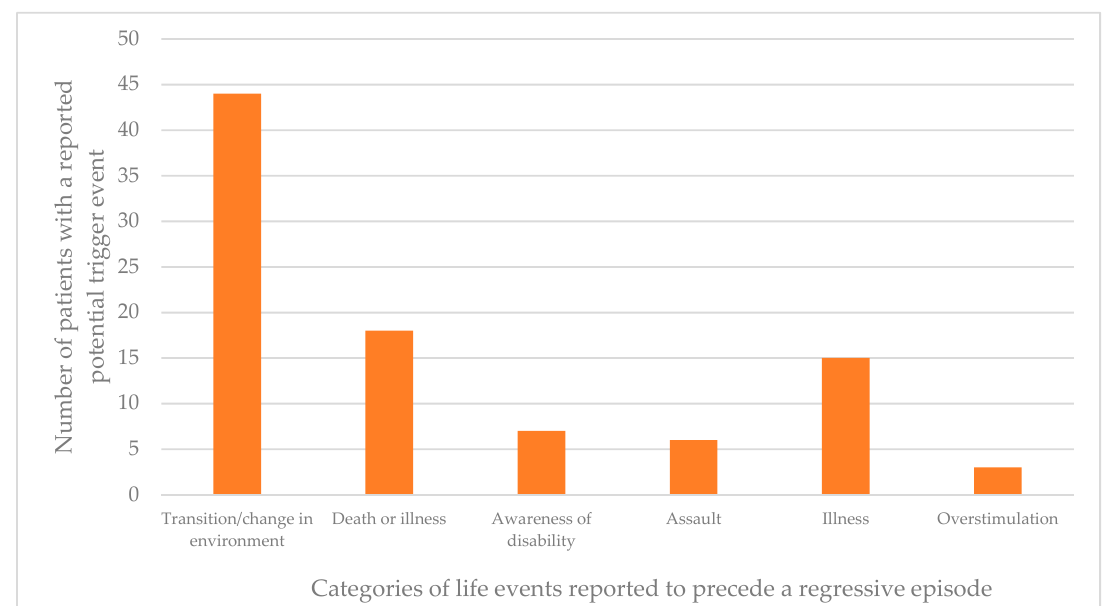
Figure 4. Number of cases with reported life events close to the time of a regressive episode ( n = 93). Events included in this figure are those that occurred in more than one individual.